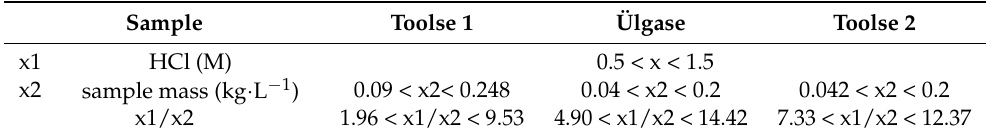
Table 6. Parameter limits used in the optimization calculations.